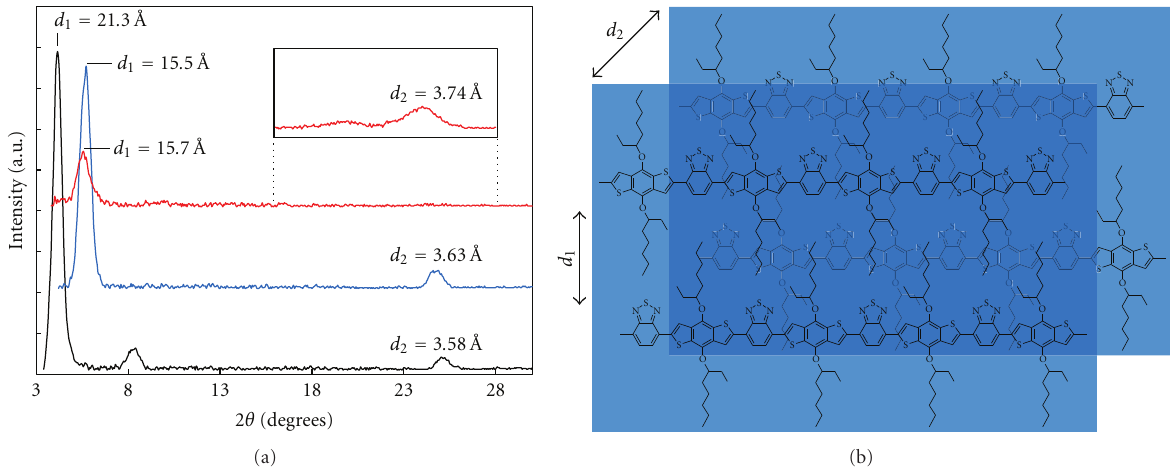
Figure 4: (a) Integrated powder di ff raction patterns for P1 (black), P2 (blue), and P3 (red). Inset: 10 frames added together for P3 . (b) Model of packing for P3 .